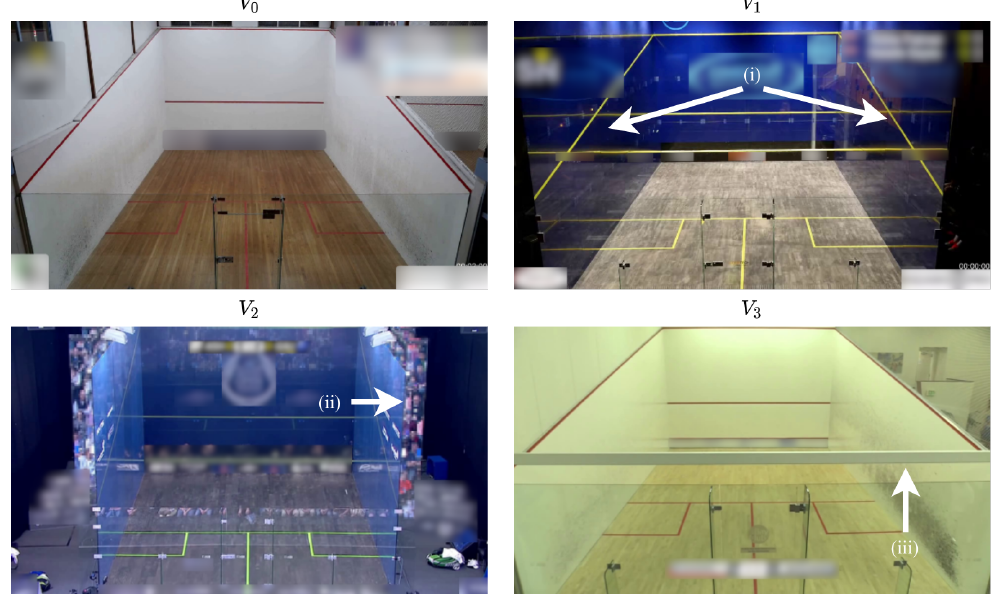
Figure 4. Example frames from videos ( V 0 – V 3 ), used to evaluate HPE-CNNs. Each image is representative of the special aspect of the respective video. ( V 0 ) is a standard court situation. ( V 1 ) shows reflections on the side walls (i) and ( V 2 ) additionally shows the mirrored audience (ii). In ( V 3 ), a supporting beam (iii) occludes the image. Please note: due to privacy reasons, players were removed and names, scores and sponsors were blurred.